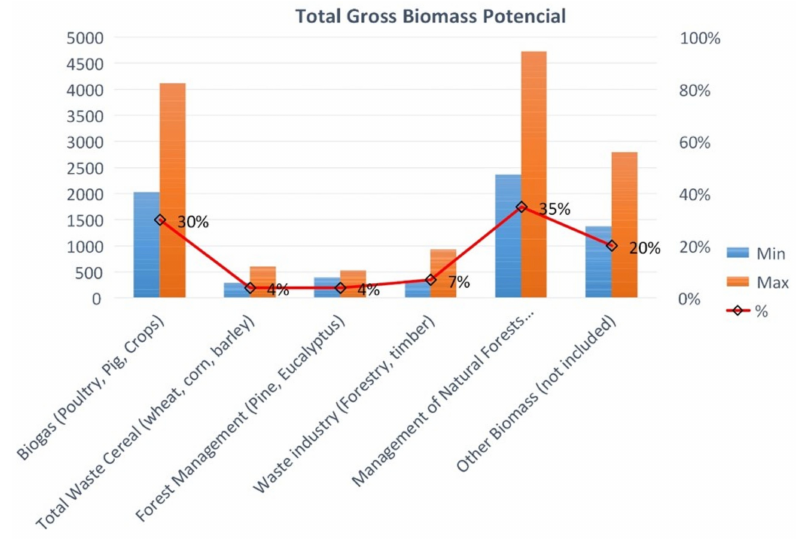
Figure 4. Gross potential in Chile per Biomass Source. From data of